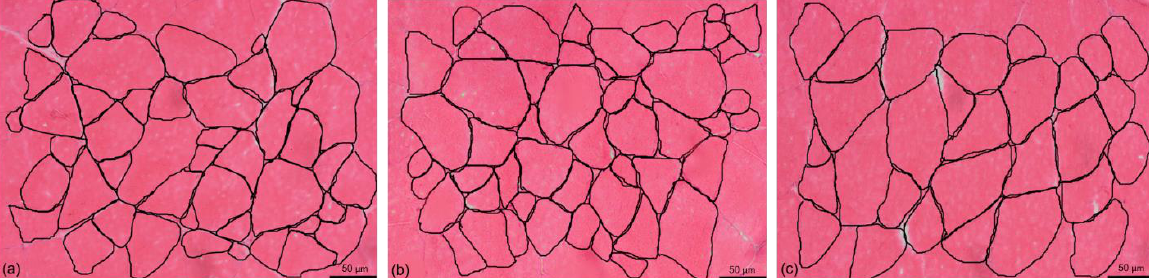
Figure 1. Cross sections of skeletal muscle from Nile Tilapia fed with the different experimental diets ( a ) REF; ( b ) OKA10; ( c ) CYOK20. Notice the larger fiber size and lower fiber density in CYOK20.